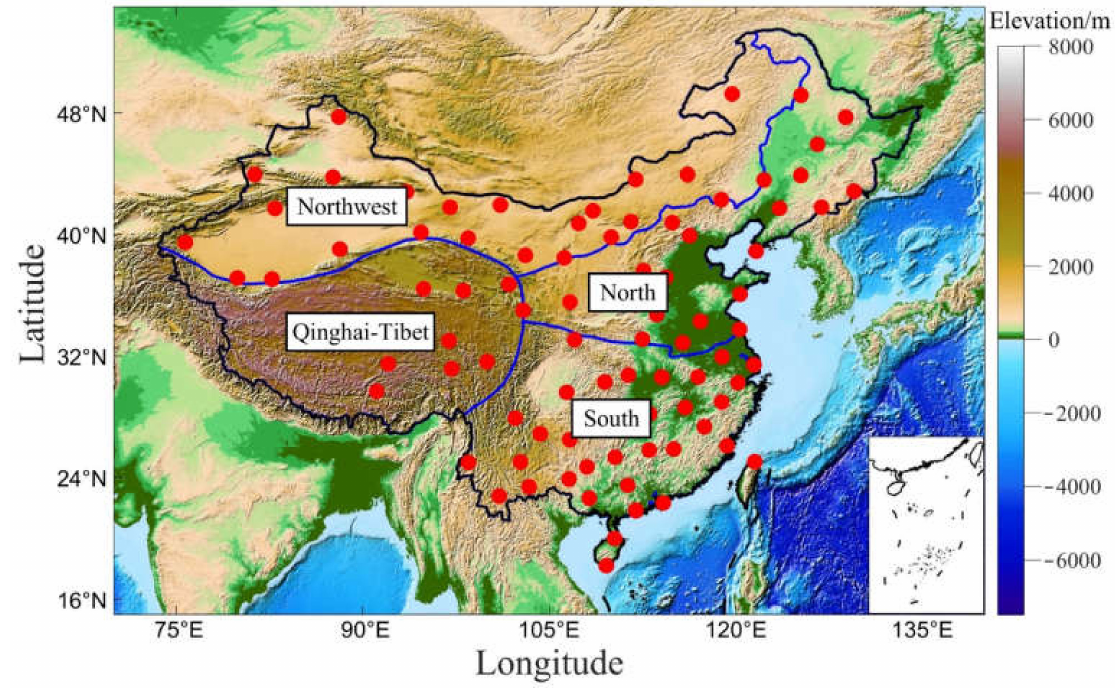
Figure 1. Geographical distribution of the 87 selected RS stations and the four geographical divisions of